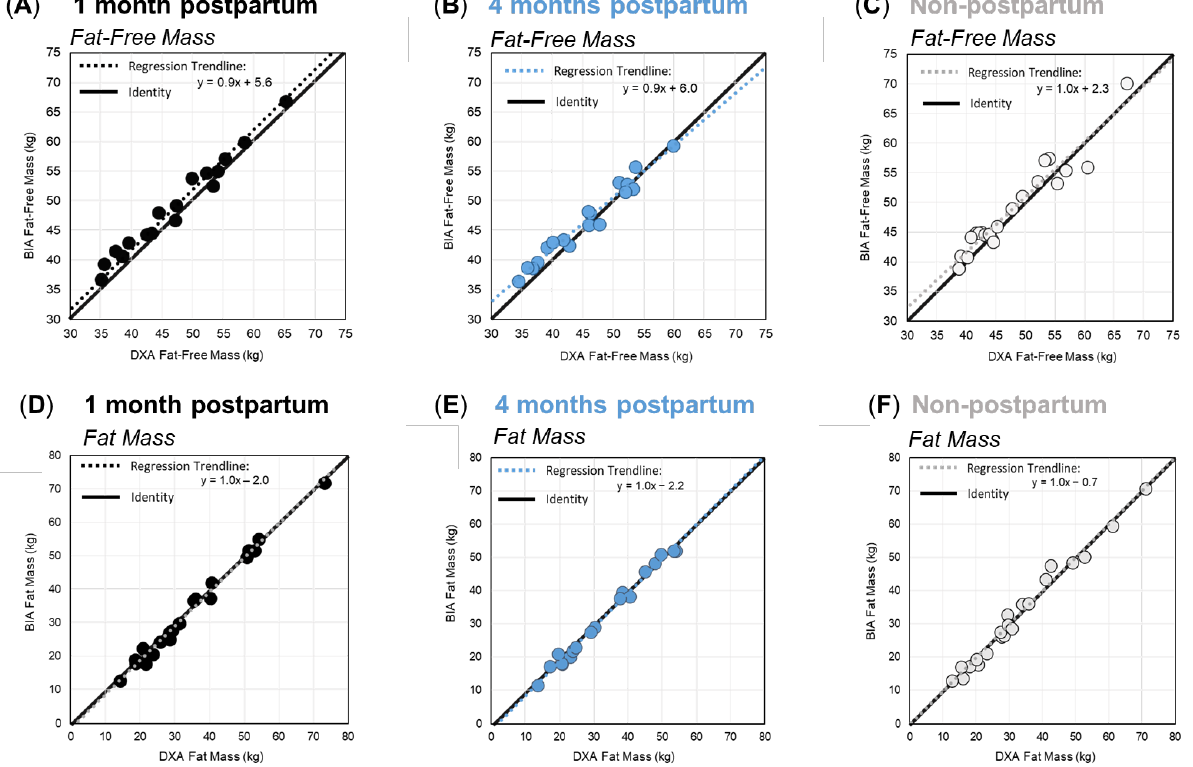
Figure 1. Deming regression plots for fat-free mass ( A – C ) and fat mass ( D – F ) for women at one month postpartum (black), four months postpartum (blue), and the non-postpartum control group (grey). Solid diagonal lines represent the line of identity, and dashed lines show the respective regression